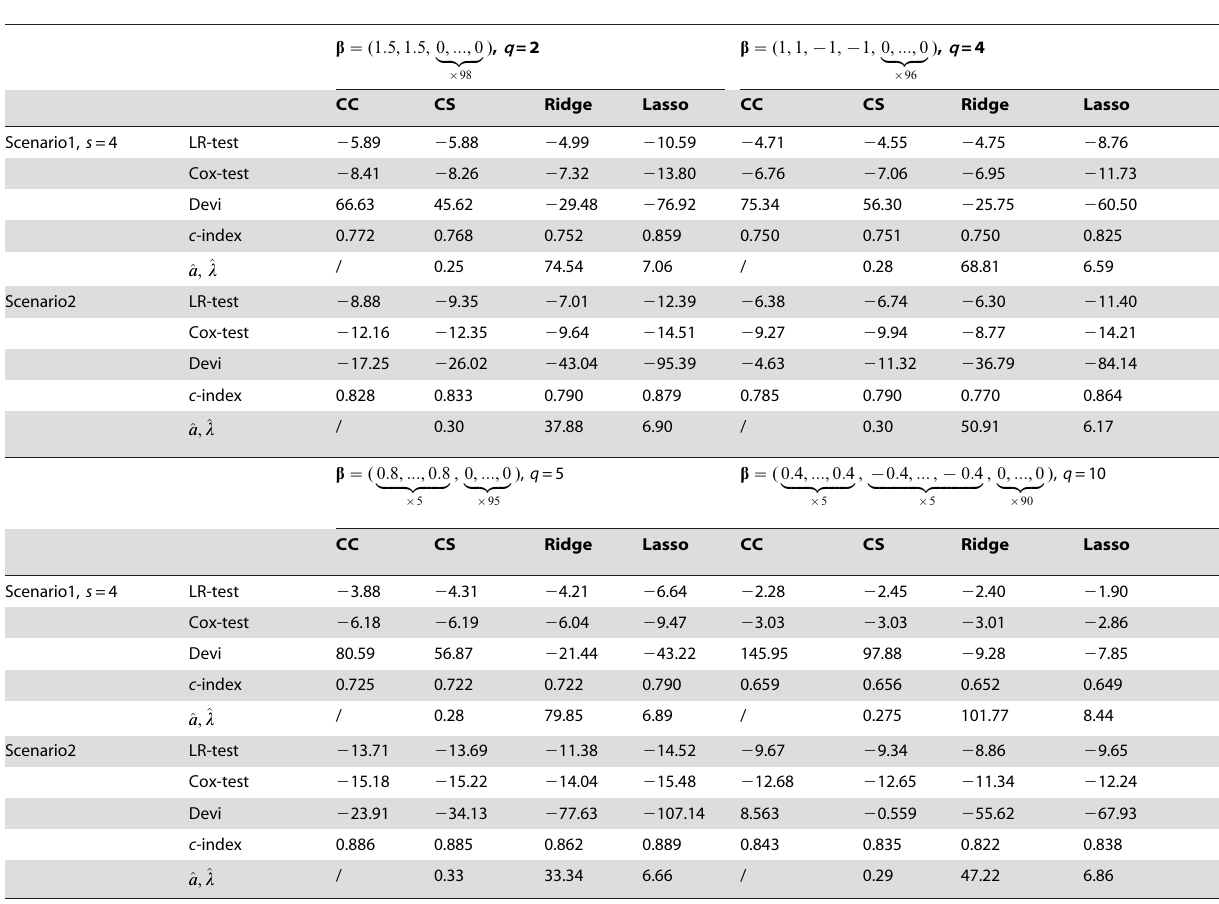
Table 1. Simulation results under sparse cases with p = 100 and n =100 based on 50